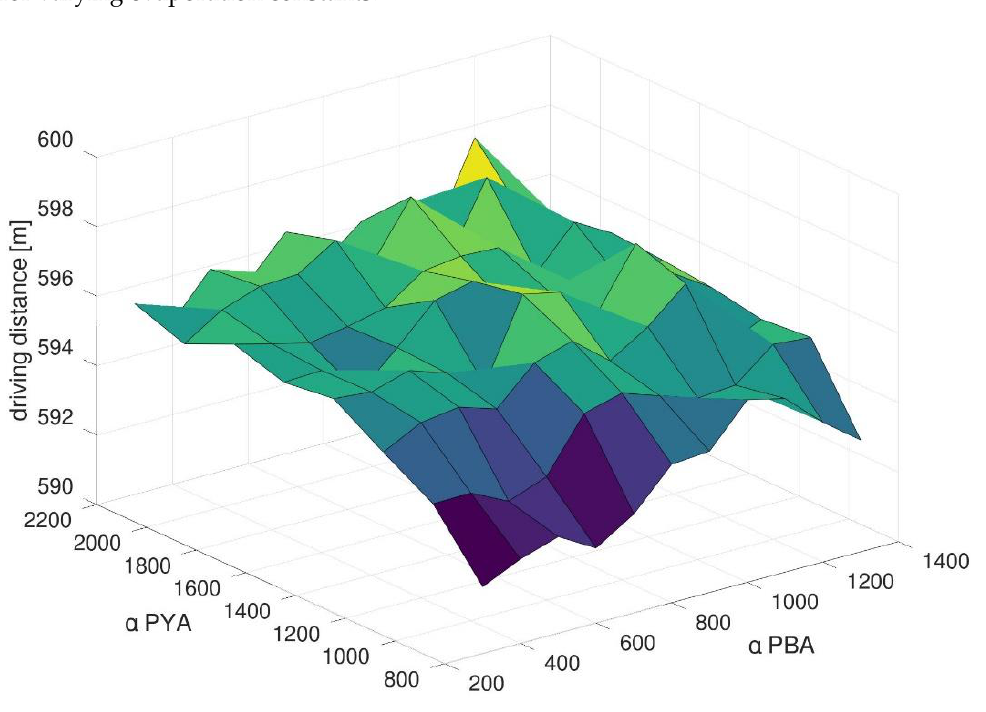
Figure 6. Impact of evaporation constants on total driving distance.